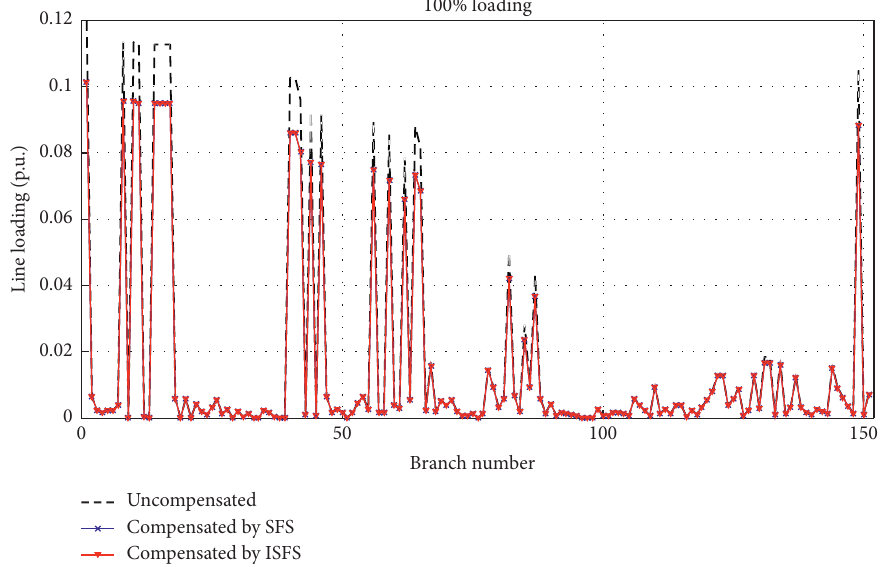
Figure 27: Line current of 152-bus network with 100% loading in scenario 1 after compensation. Table 13: On/off scheduling of switched SCs by ISFS and SFS for 152-bus